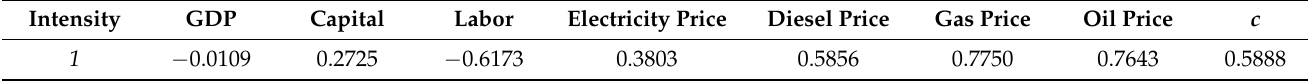
Table 8. Estimated long-term elasticity using normalized coefficients based on energy intensity. Intensity GDP